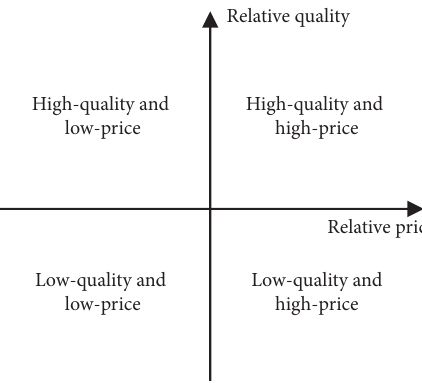
Figure 1: Enterprise’s exporting competition